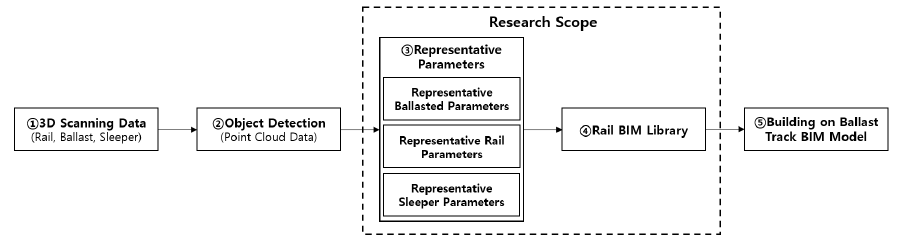
Figure 1. Object detection-based Scan-to-BIM process and research scope.